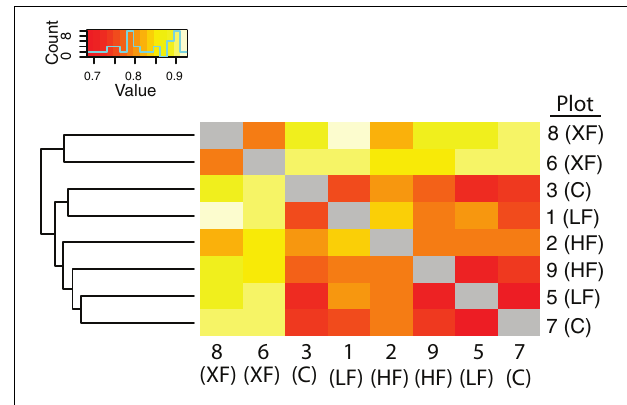
FIGURE 6 | Heat map of the frequency of co-occurrence of bacterial taxa among the marsh plots. The less frequent the co-occurrence the warmer the colors. Hierarchical clustering indicates two clusters, one containing the XF plots and the other containing all six remaining